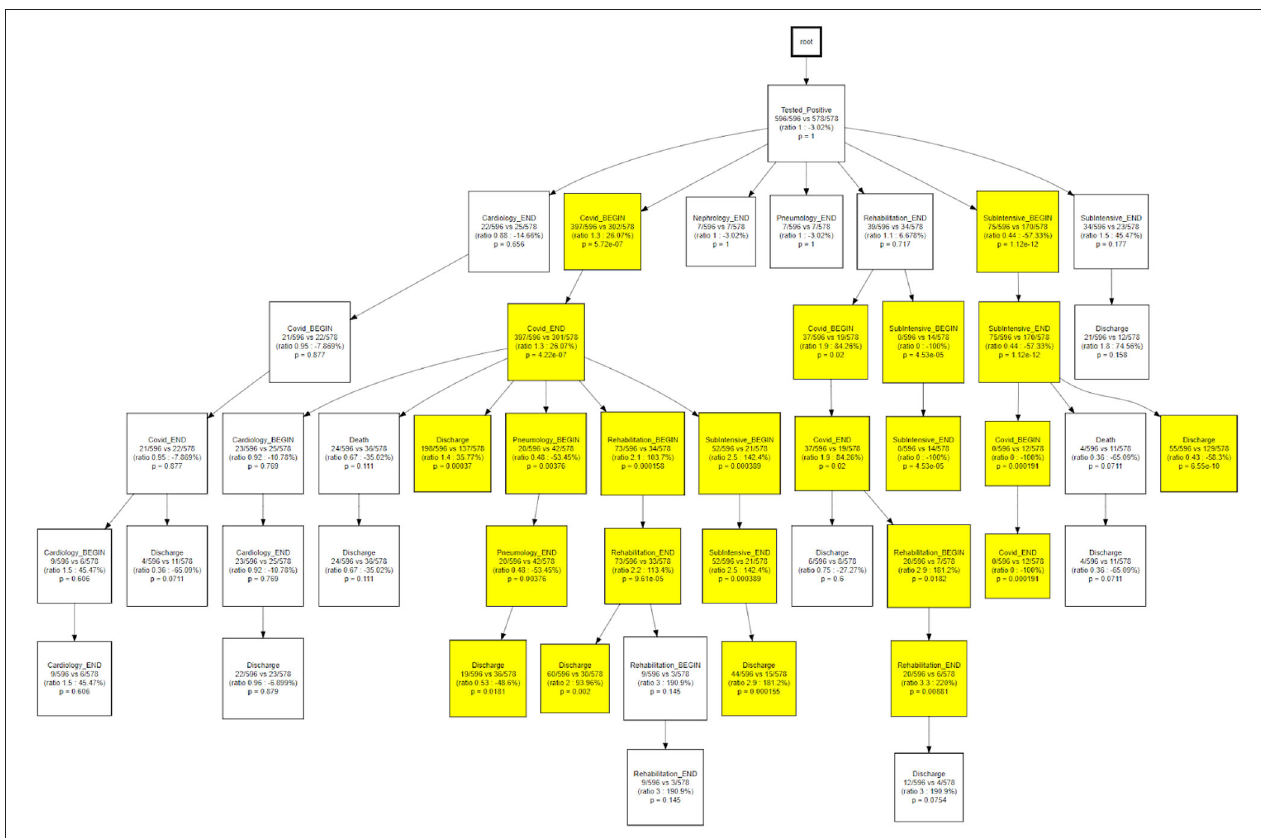
FIGURE 11 | CareFlow miner results - waves